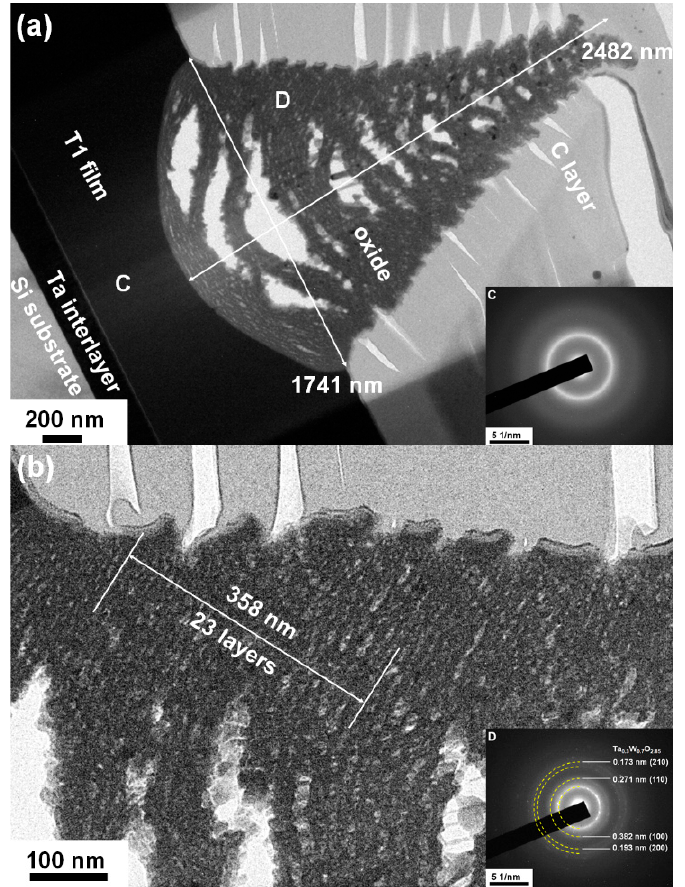
Figure 14. ( a ) XTEM image and SAED patterns and ( b ) magnified XTEM image of the T2 sample annealed at 600 °C in 1% O 2 –Ar for 8 h.